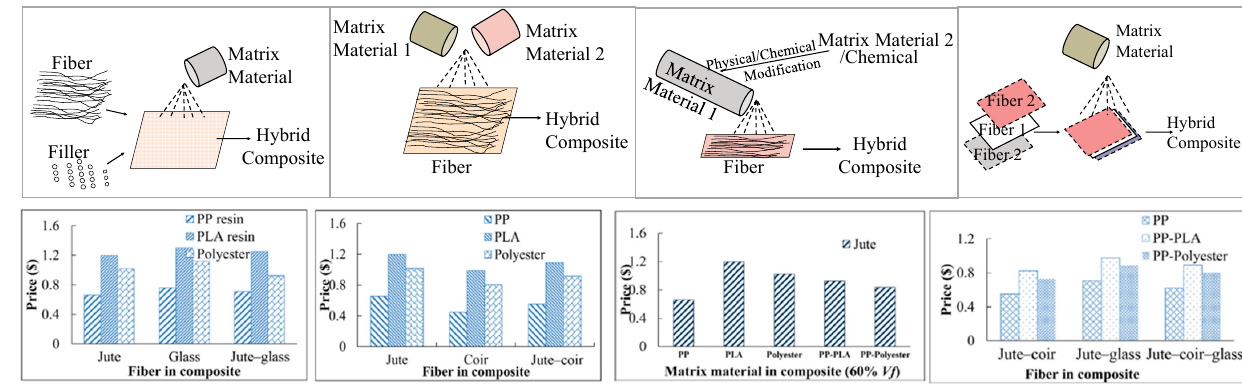
Figure 19. Schematic diagrams of hybrid composite designs and some cost estimation [54].